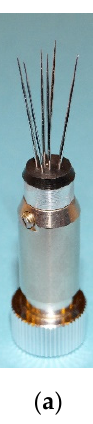
Figure 1. Photograph of the thermal wave anemometer probe ( a ) and a diagram of its geometric configuration ( b ). The wires (invisible on the photograph and shown on the diagram as black lines) are welded at the tips of the supports.